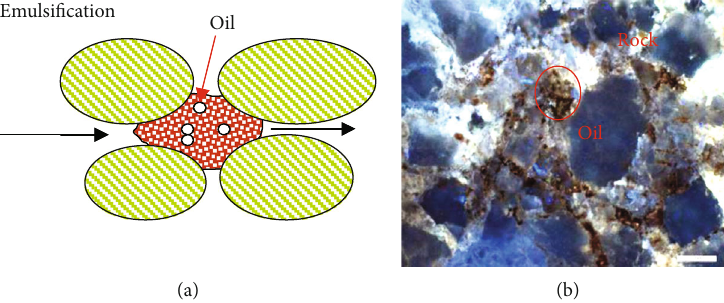
Figure 19: Reasons for changes in crude oil viscosity to form residual oil. (a) Schematic. (b) Fluorescent picture.